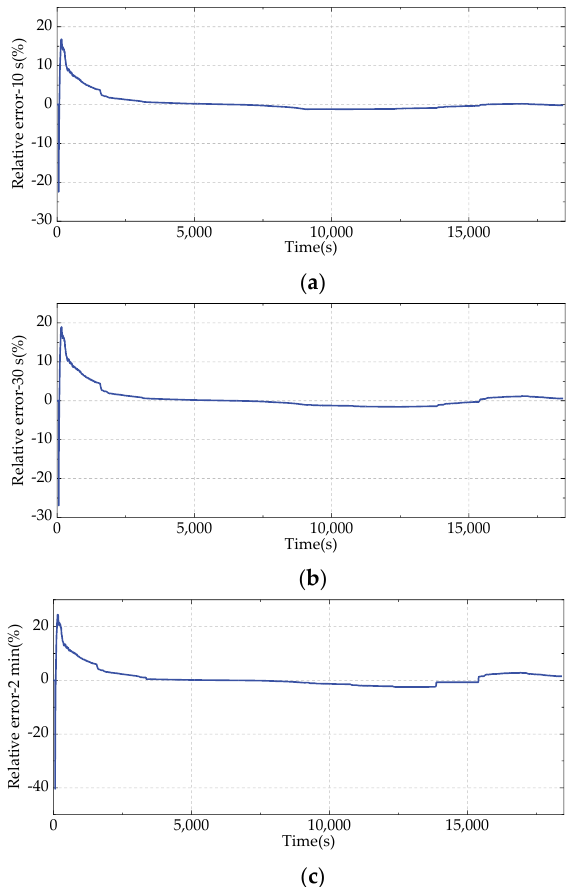
Figure 19. Results of peak charge power estimation: ( a ) 10 s; ( b ) 30 s; ( c ) 2 min.